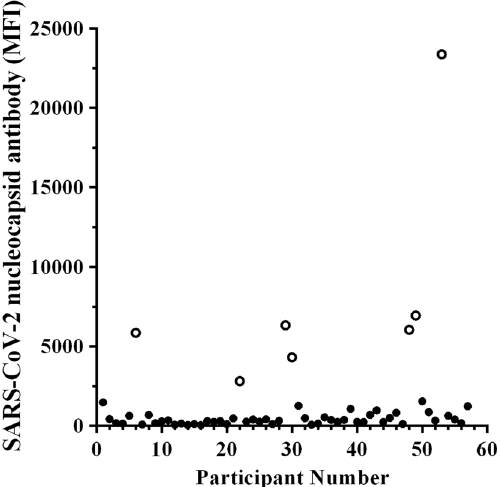
Figure 1. SARS-CoV-2 nucleocapsid-specific serum antibody levels amongst participants ( N = 57). MFI = median fluorescence intensity. Open circles indicate the participants likely to have had a previous SARS- CoV-2